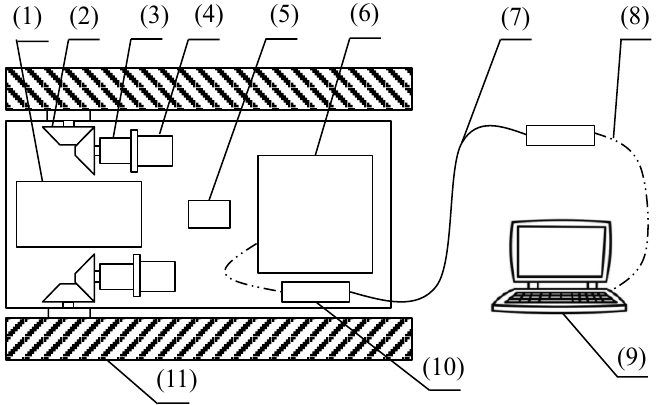
Figure 11. Schematic diagram of the unmanned tracked vehicle. (1) 24 V battery; (2) bevel gear; (3) planetary reducer; (4) brushless DC motor; (5) inertial measurement unit; (6) industrial controlling computer; (7) optical fiber; (8) network cable; (9) computer; (10) fiber optical transceiver; (11) track.